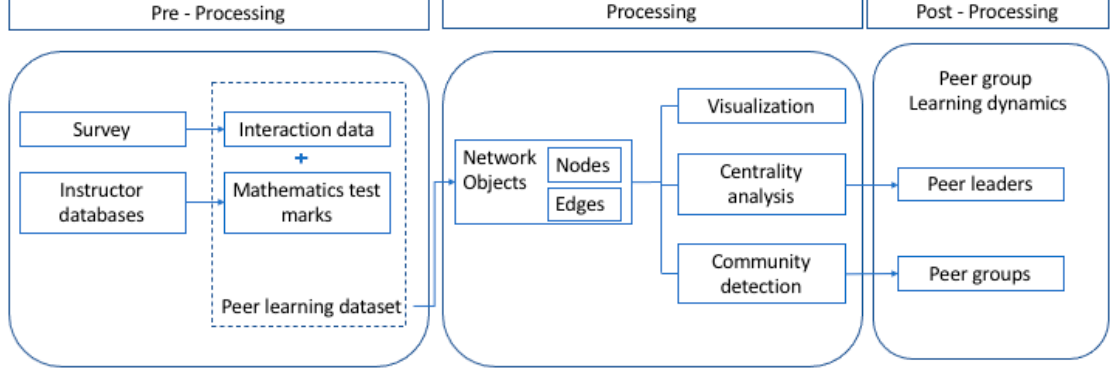
Figure 1. The framework adopted in the study.